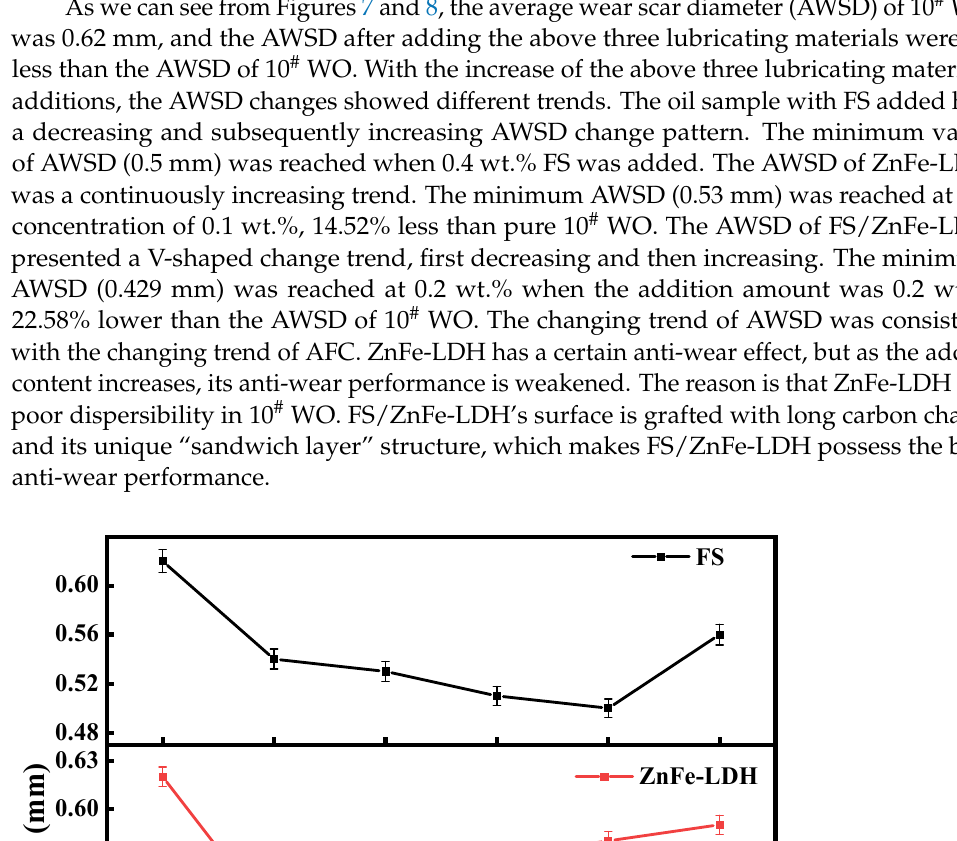
Figure 7. The morphology of the lower test ball wear scars.